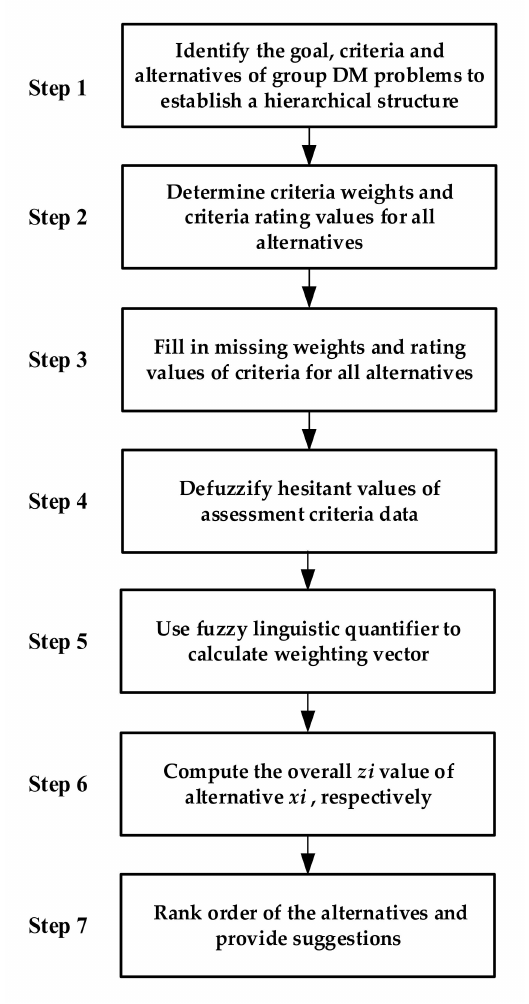
Figure 1. The flow chart of proposed novel group decision-making (DM)